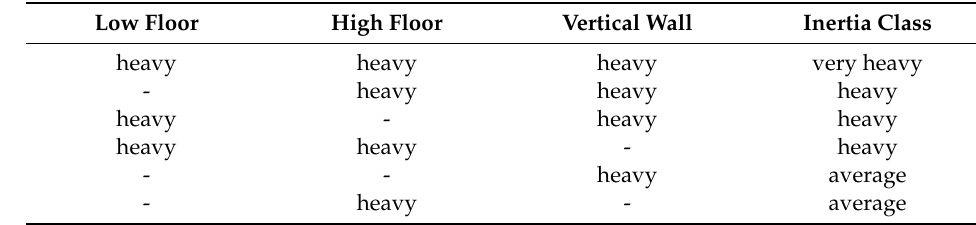
Table A1. Inertia classes for building.